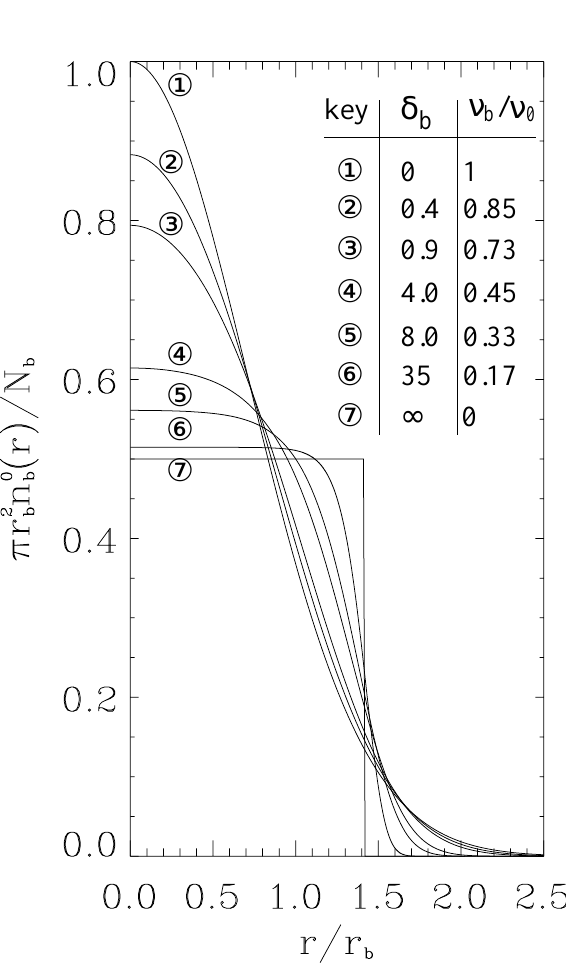
FIG. 1. Plot of normalized density profile p r 2 b n 0 b (cid:1) r (cid:2)(cid:3) N b ver- sus r (cid:3) r b for several values of normalized beam intensity d b (cid:1) N b Z 2 b e 2 (cid:3) 2 g 2 b T b and corresponding values of tune depres- sion n b (cid:3) n 0 .